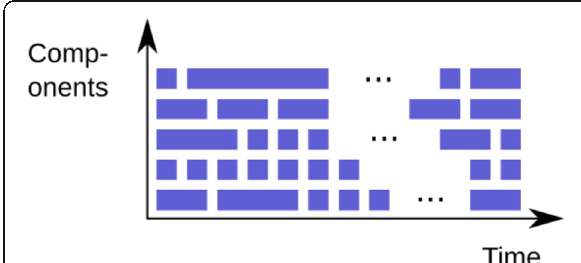
Fig. 1 (Abstract P3). Left: the operational variables in a full- resolution model. Right: the same model, but some of the variables have been aggregated. Each block represents the operational variable (e.g. production level) of a component at a particular time